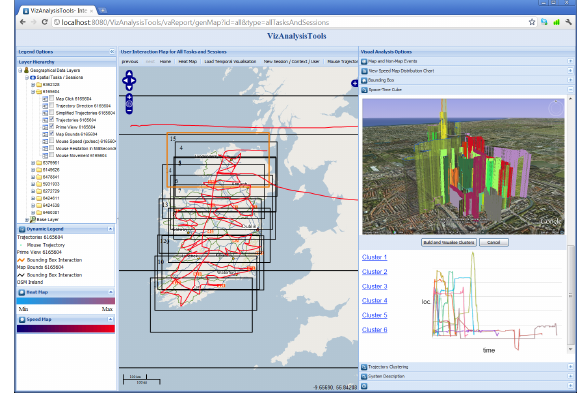
Figure 1: Geovis tool showing different functionality